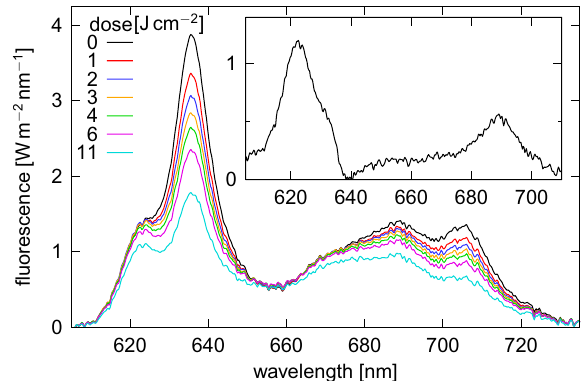
Fig. 5. Bleaching of the °uorescence of MAL-treated lesion of rat No. 6, which exhibits also contribution of luminescence of uroporphyrin and/or coproporphyrin. Inset: The emission spectrum of these two species obtained from the unbleached spectrum (dose of 0 Jcm (cid:4) 2 ) by subtracting the two principal components obtained by